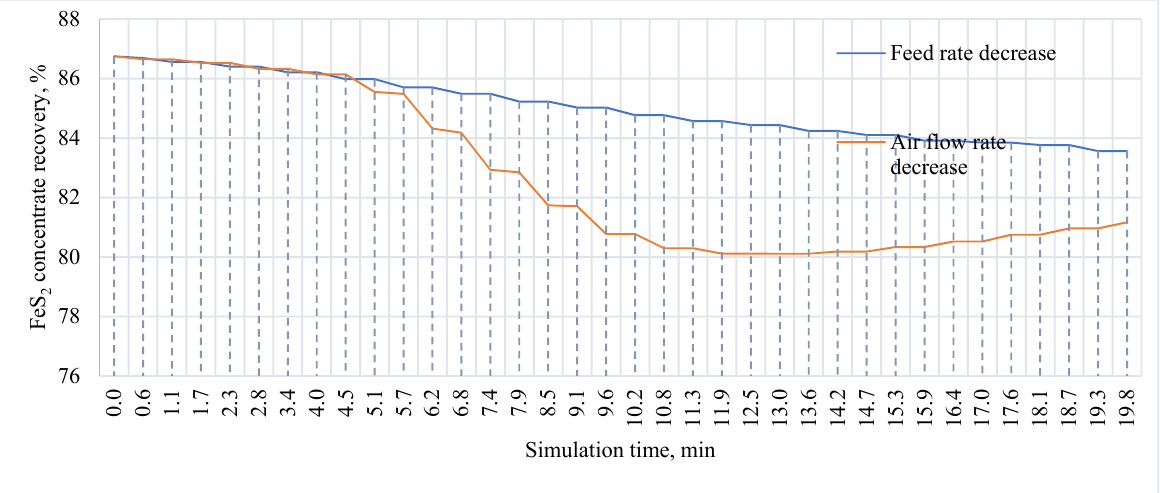
Figure 12. Froth height values in the simulation.